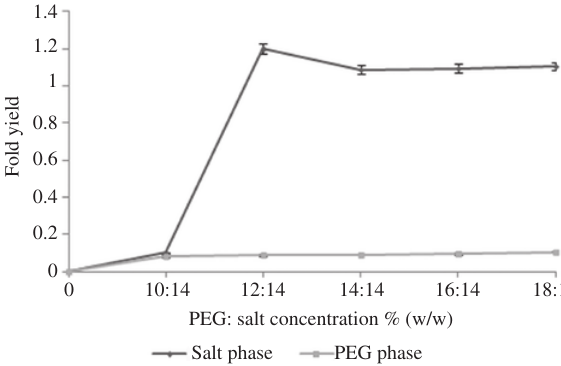
Figure 4: β -Glucosidase production at different salt concentrations. pH 4.0 and temperature 30 ° C.